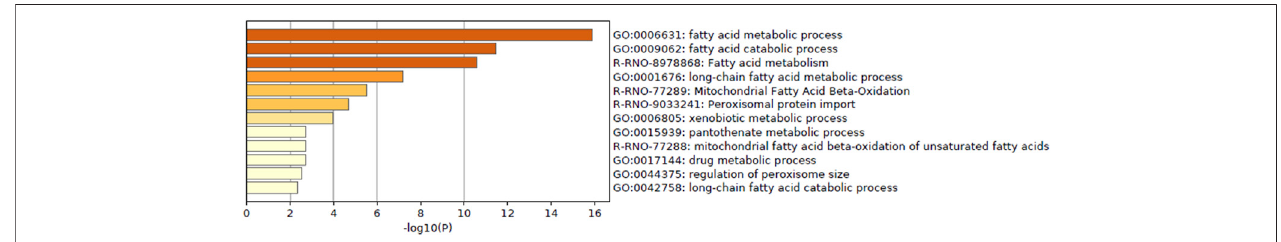
FIGURE 5 | Enrichment analysis of in vitro – in vivo extrapolation (IVIVE) – related genes identi fi ed in a virtual microarray (RAID) system. Top 20 most important (contribution) genes from the predictive models were analyzed.